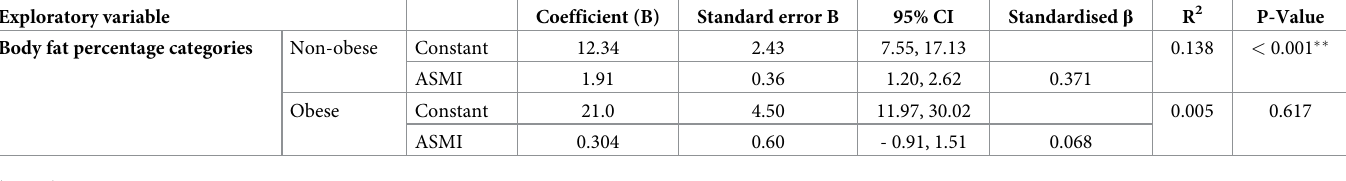
Table 4. Results of multiple linear regression modelling on the effect of obesity in the relationship between muscle strength and mass in older females. Exploratory variable